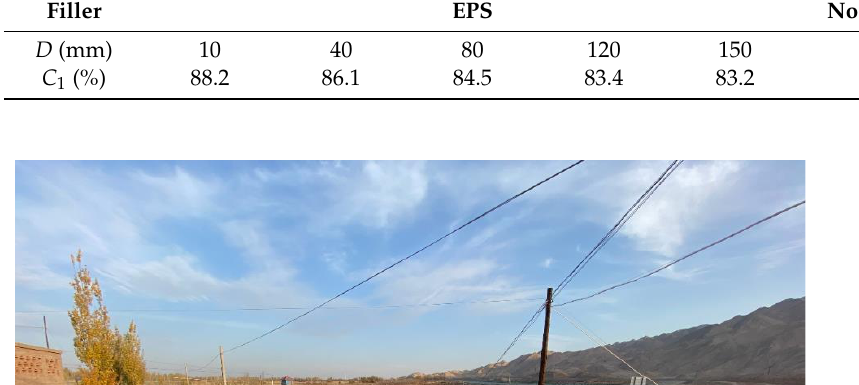
Table 1. Evaporator test design.